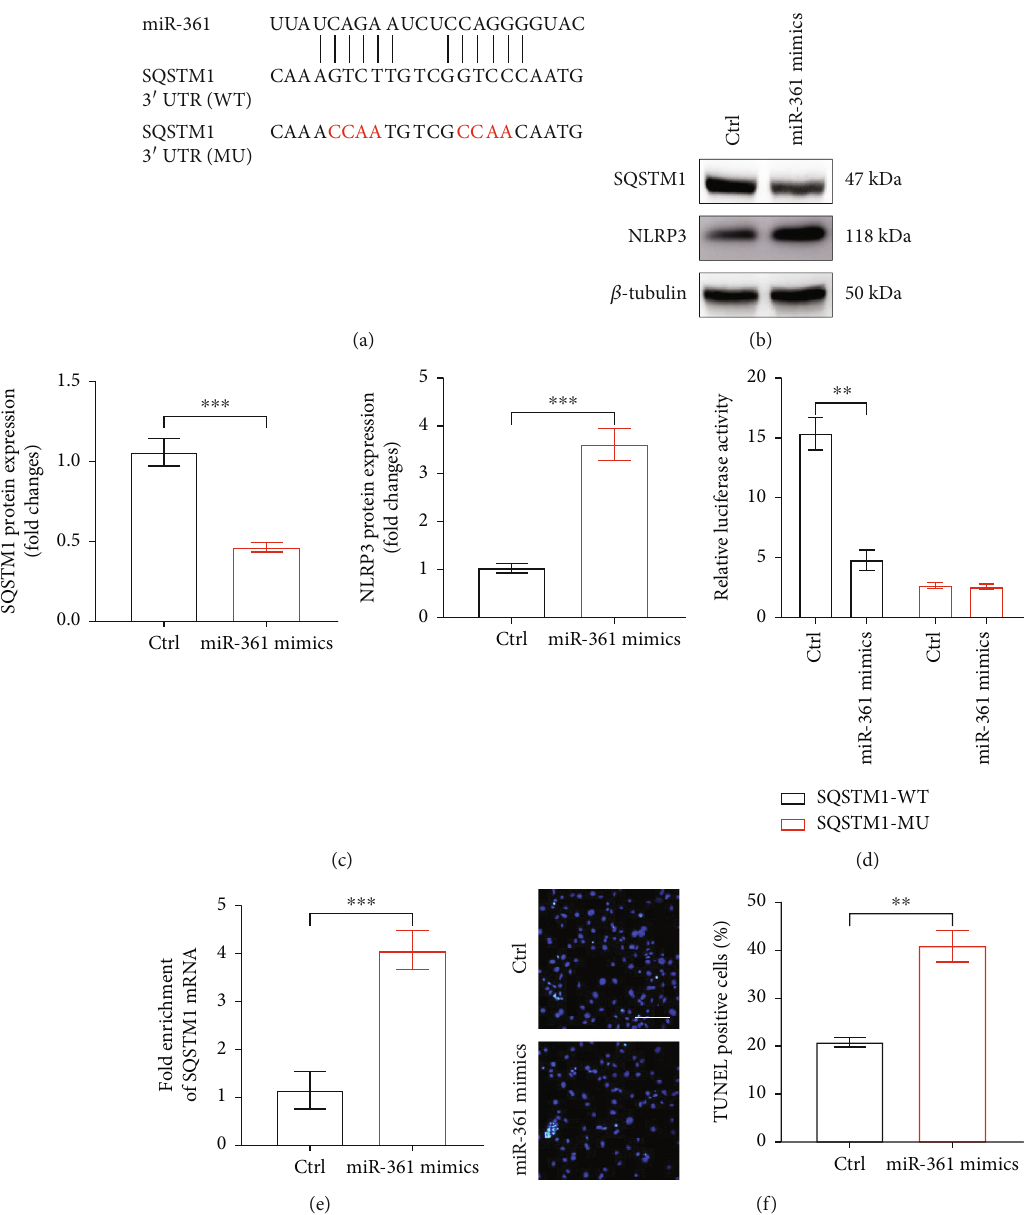
Figure 6: miR-361 binds to SQSTM1 and suppresses SQSTM1/NLRP3. (a) The putative targeting site of SQSTM1 and miR-361 was predicted by Targetscan and PicTar. (b) SQSTM1 and NLRP3 protein expression in MSMCs transfected with miR-361 mimics or control (ctrl). (c) Quanti fi cation of SQSTM1 and NLRP3 protein expression on western blots. (d) Luciferase activities were measured in HEK- 293T cells transfected with SQSTM1-WT or SQSTM1-MU luciferase reporter vector, along with ctrl or miR-361 mimics. (e) MiR-361 binds to MDRL. Biotin-conjugated pulldown assay and qRT-PCR were performed in MSMCs. (f) Representative images of TUNEL staining in MSMCs transfected with ctrl or miR-361 mimics, and quanti fi cation of TUNEL-positive cells. Scale bar: 50 μ m. Data are presented as mean ± SEM. ∗∗ P < 0 : 001 vs ctrl